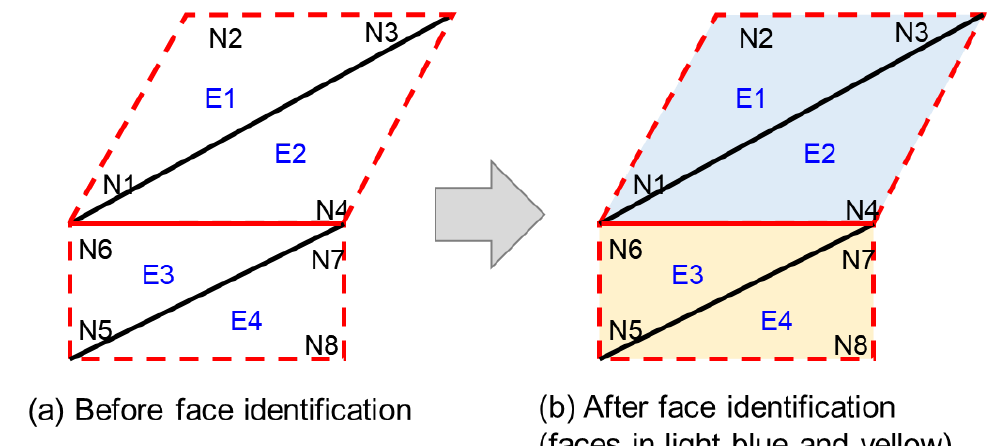
Figure 5. Identification of faces of a mesh model.